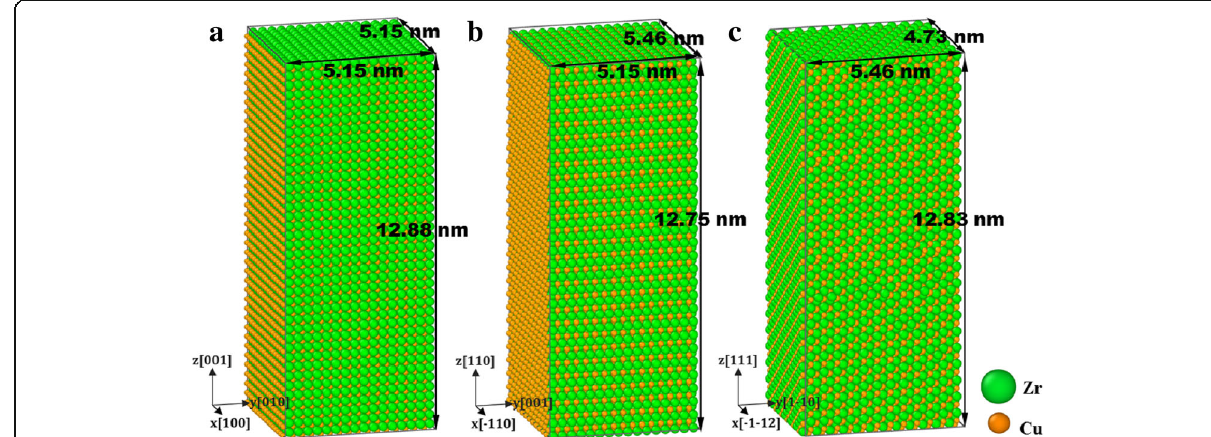
Fig. 1 Samples with axial z along a [001], b [110], and c [111], colored with atomic